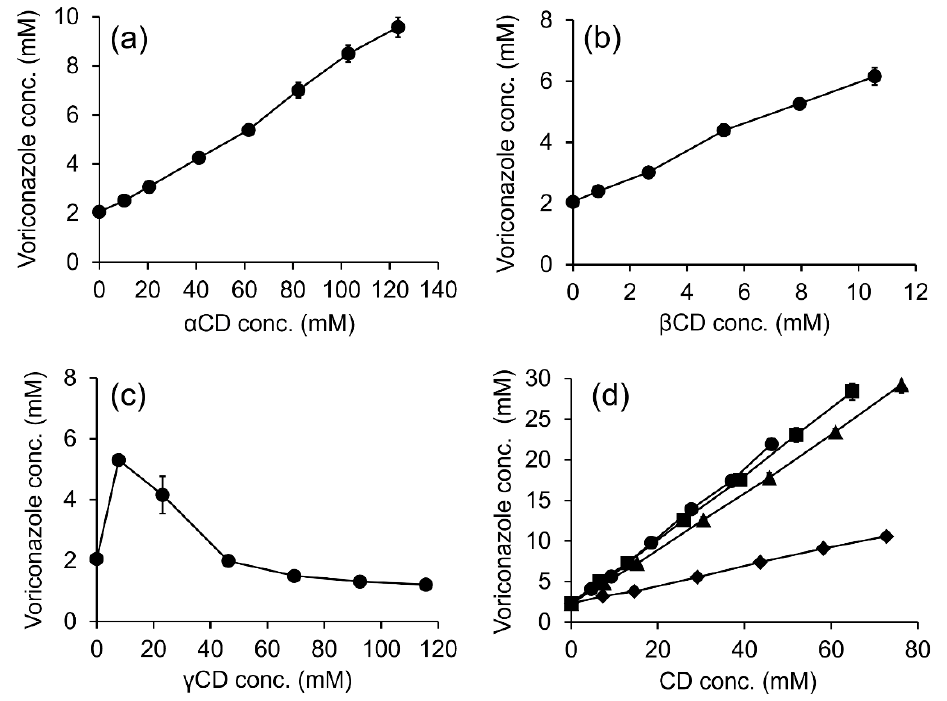
Figure 1. Phase-solubility profiles of VCZ in aqueous CD solutions; α CD ( a ), β CD ( b ), γ CD ( c ) and β CD derivatives, i.e., SBE β CD ( ● ), HP β CD ( ■ ), RM β CD ( ▲ ) and CM β CD ( ♦ ) ( d ). The values of the apparent stability constant (K 1:1 ) and the complexation efficiency (CE) of VCZ/CD complexes are displayed in Table 2. VCZ had a 10-fold higher affinity to β CD than α CD. However, the molecular rigidity and strong intermolecular hydrogen bonding in the crystal state resulted in limited solubility of native β CD in an aqueous medium. Attachment of substituent groups can favor β CD interaction with the surround- ing water molecules and the random distribution of the substituents, both of which will increase aqueous β CD solubility [28,29]. Hence, β CD derivatives, i.e., HP β CD, randomly methylated β -cyclodextrin (RM β CD), SBE β CD and carboxymethyl β -cyclodextrin (CM β CD), were further investigated for VCZ solubility enhancement. The phase-solubil- ity diagrams of VCZ in all tested β CD derivatives represented the A L type, which re- mained unchanged from its parent β CD (Figure 1d). The β CD derivative ranking regard- ing K 1:1 and CE values was as follows: SBE β CD > HP β CD > RM β CD >> CM β CD (Table 2). The significant distance between SBE β CD torus and the charged sulfonate moiety reduced the steric interference and increased the binding potential when compared with the other β CD derivatives. In addition, the long alkyl chain length acted as a supplementary bind- ing site for substrates [30,31] . Based on the solubility determination data, SBE β CD was selected for further studies. Table 2. Apparent stability constants (K 1:1 ) and the complexation efficiency (CE) values of VCZ/CD complexes in aqueous solutions with and without individual polymers at 30 °C ± 1 °C (mean, n = 3). Cyclodextrin